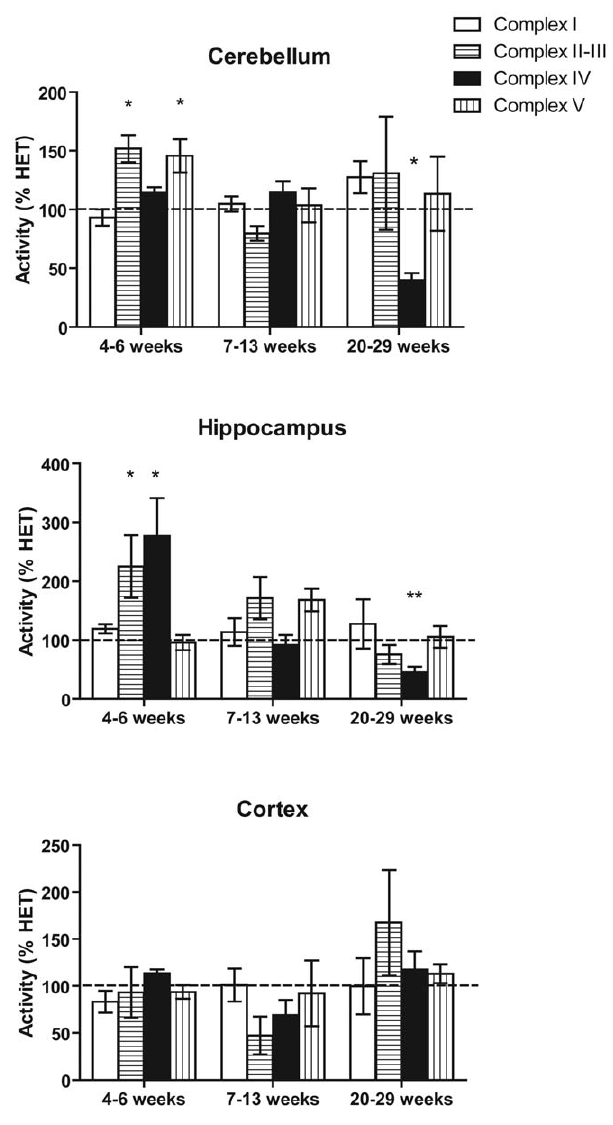
Figure 2. Changes in ETC activities in cerebellum, hippocam- pus and cortex in HET and HET-CRE mice. Enzymatic activities were evaluated as described in the Materials and Methods section and originally expressed as nmol 6 (min 6 mg protein) 2 1 and normalized to citrate synthase activity for each brain region and age. Complex I activity was evaluated by measuring either NFR (cerebellum and hippocampus) or NQR (cortex) activities. Data were expressed as percentage of HET values (mean 6 SEM) and analyzed by unpaired t test. * p , 0.05 compared with HET.